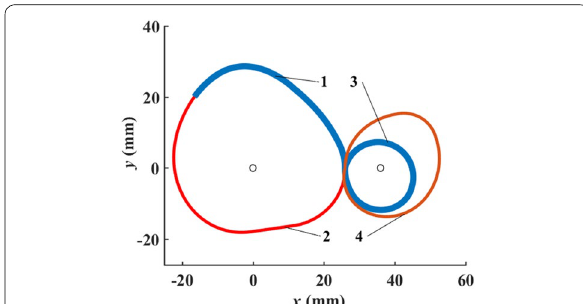
Figure 8 Pitch curves of the two pairs of main driven gears. 1. Pitch curve of the first driving gear; 2. Pitch curve of the second driving gear; 3. Pitch curve of the first driven gear; 4. Pitch curve of the second driven gear